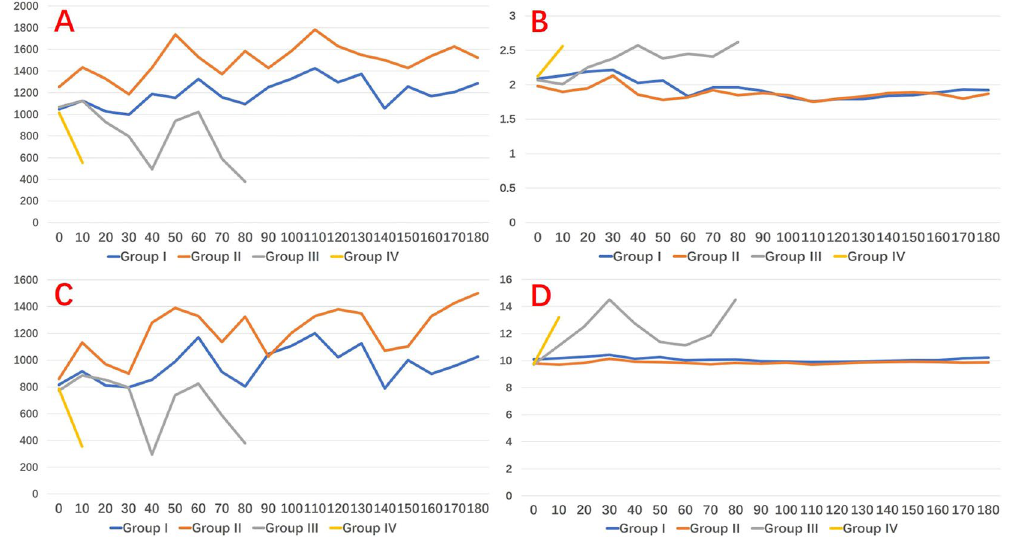
Figure 7. EMG signal profiles: ( A ) RLN amplitude; ( B ) RLN latency; ( C ) VN amplitude; ( D ) VN